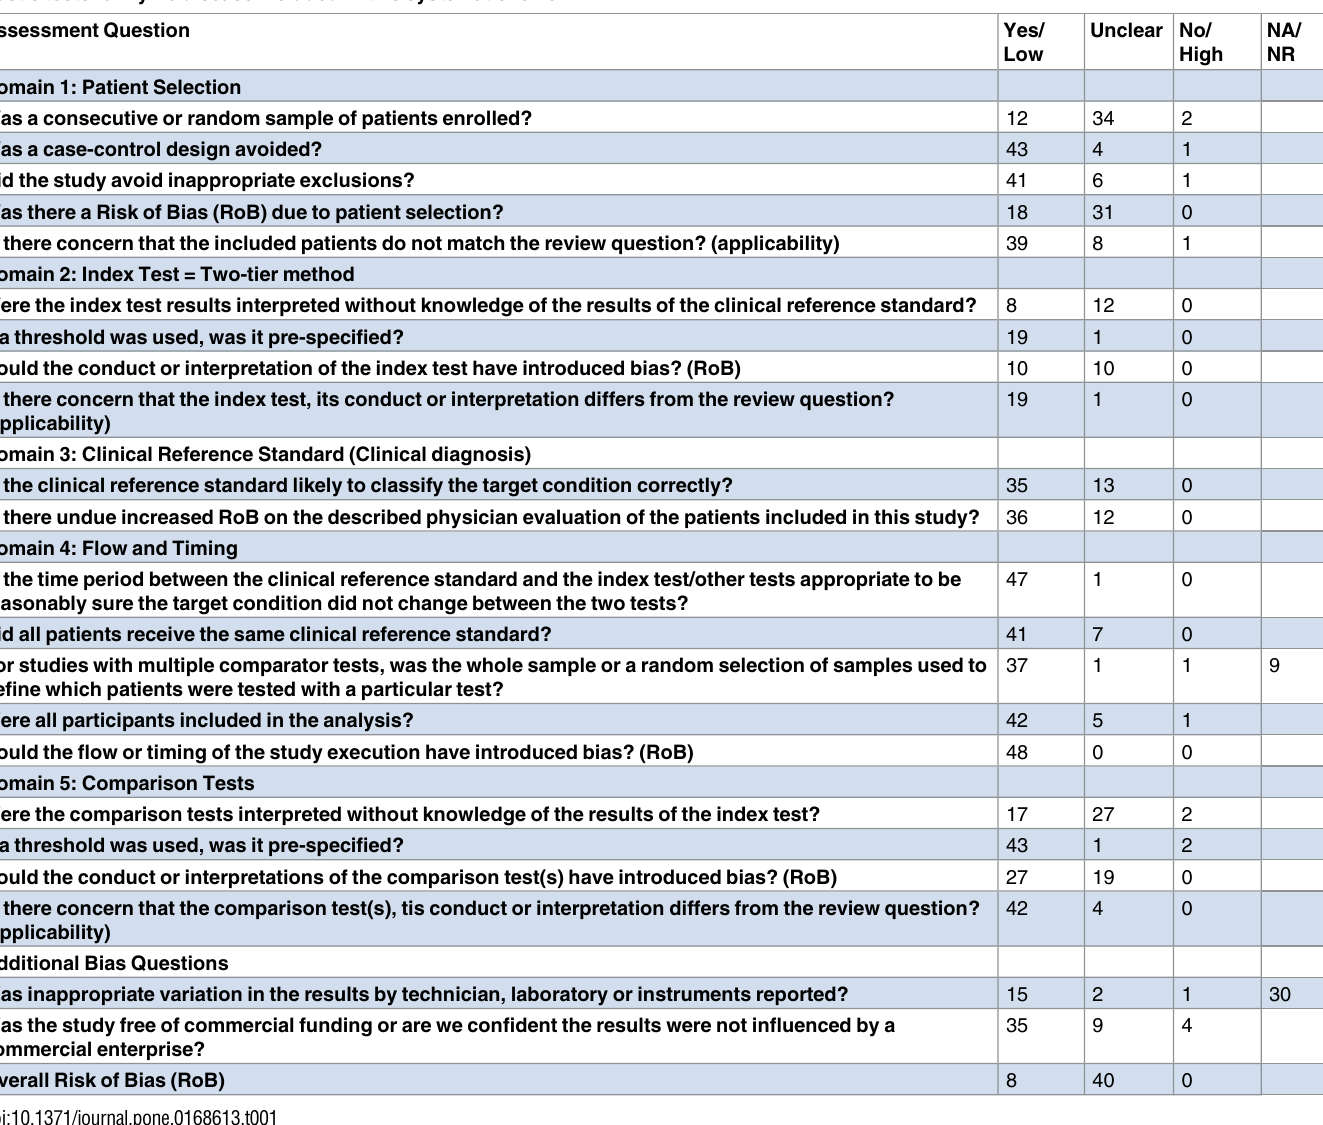
Table 1. Number of studies meeting each quality criteriain QUADAS-2 based on 48 articles from the United States examining the accuracyof diag- nostic tests for Lyme disease included in this